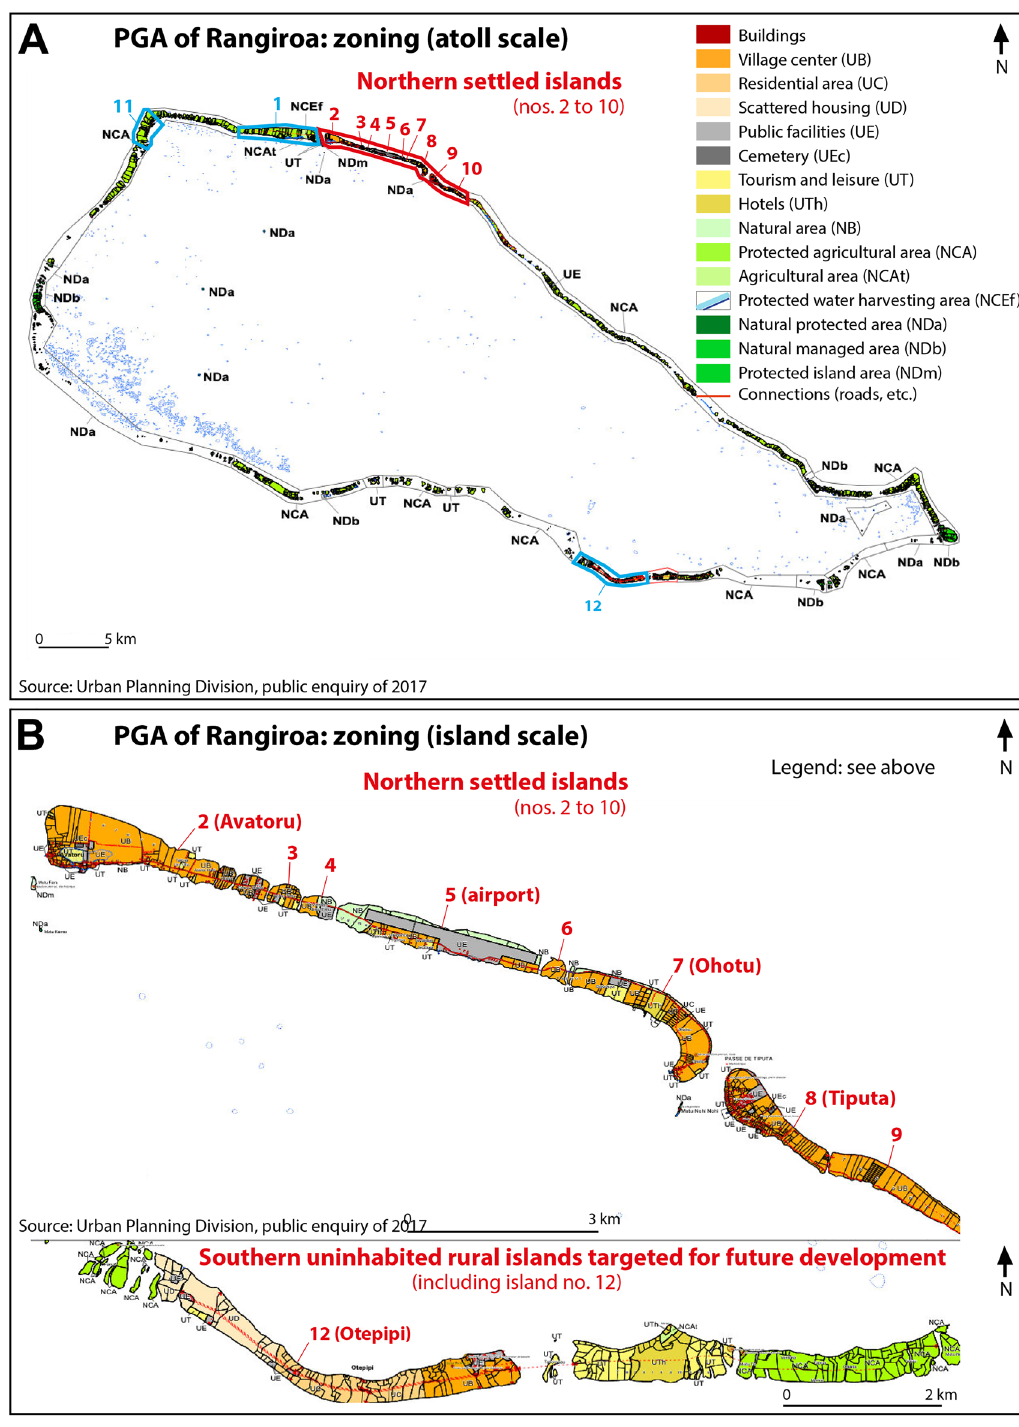
Figure 8. Mapping of the PGA of Rangiroa. ( A ) provides a general map on the atoll scale. ( B ) zooms in on the two critical areas considered in this study, including, on the top, the settled area, and at the bottom, the uninhabited southern rural islands (including no. 12, Otepipi) targeted for future development. ( B ) shows that these islands are planned to become a residential area (no. 12), with jobs being provided in nearby tourist (in yellow) and agricultural (in green) islands. Public facilities will be developed, including connections between islands. Source: Ref. 61